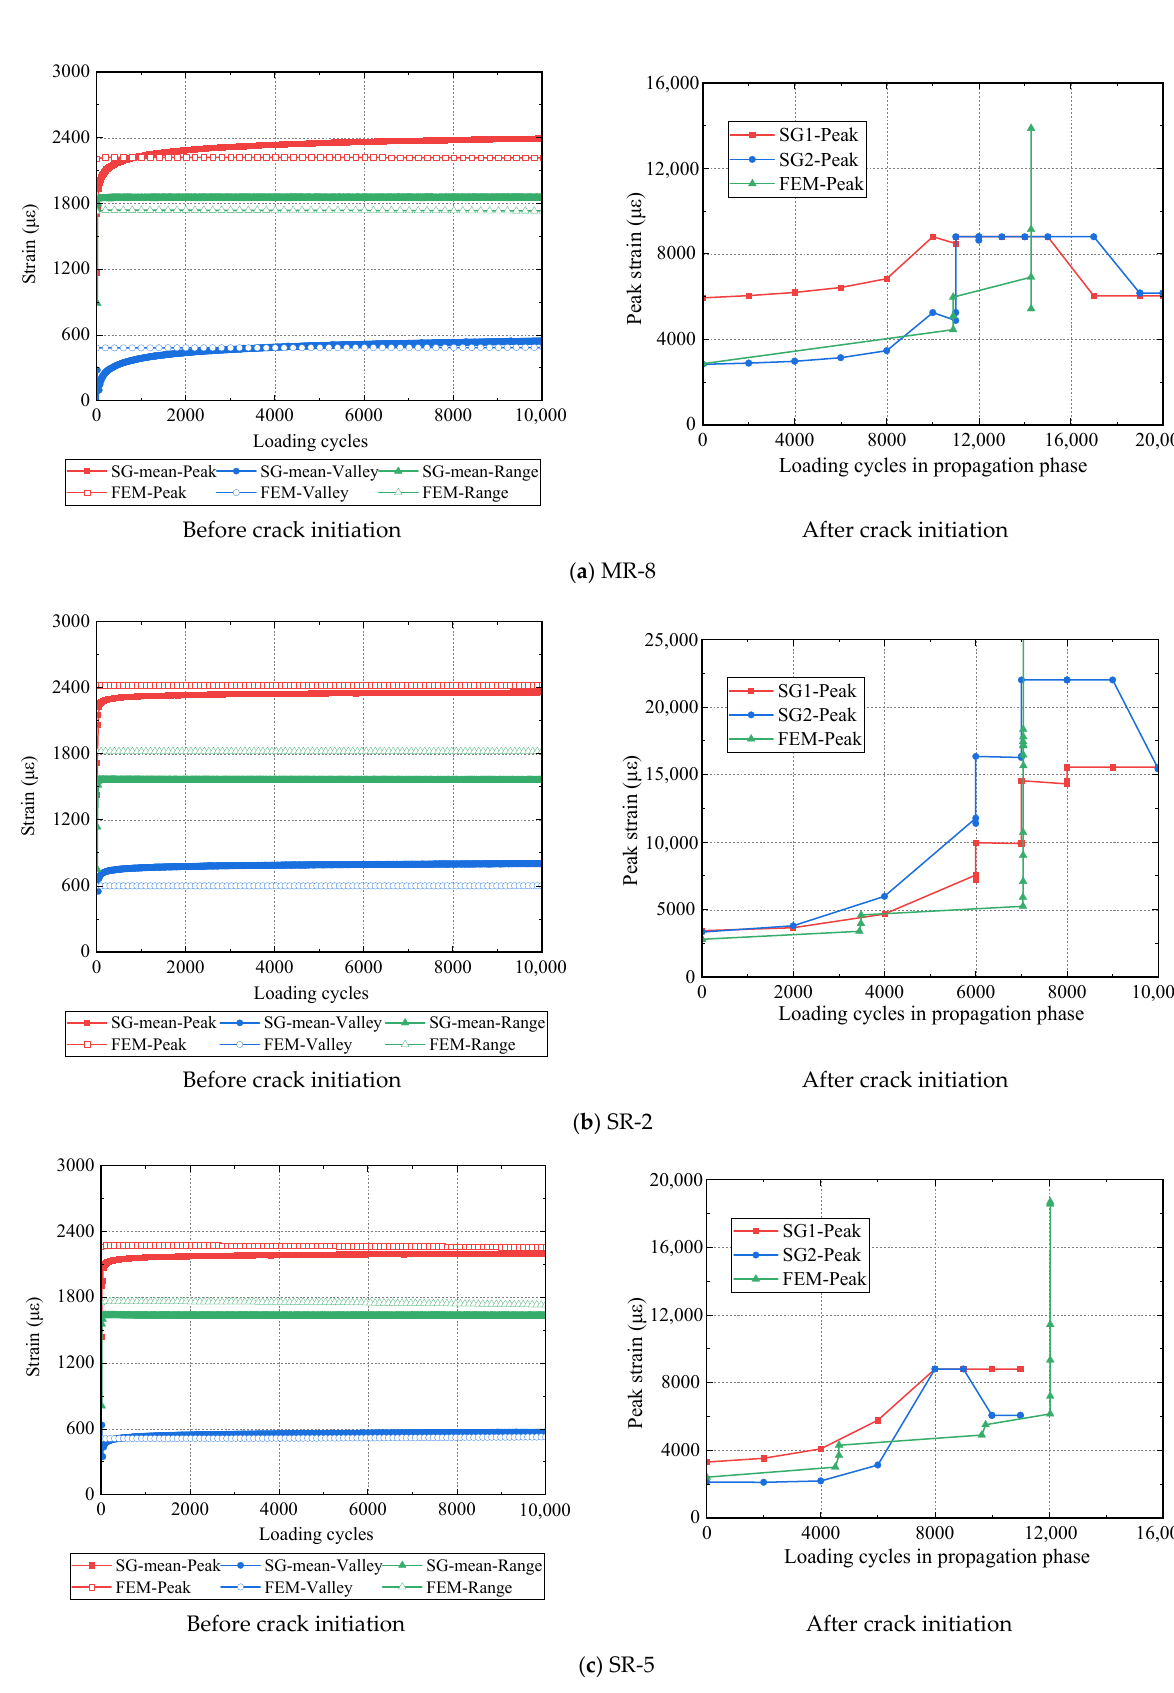
Figure 13. Experimental and predicted strain evolutions.